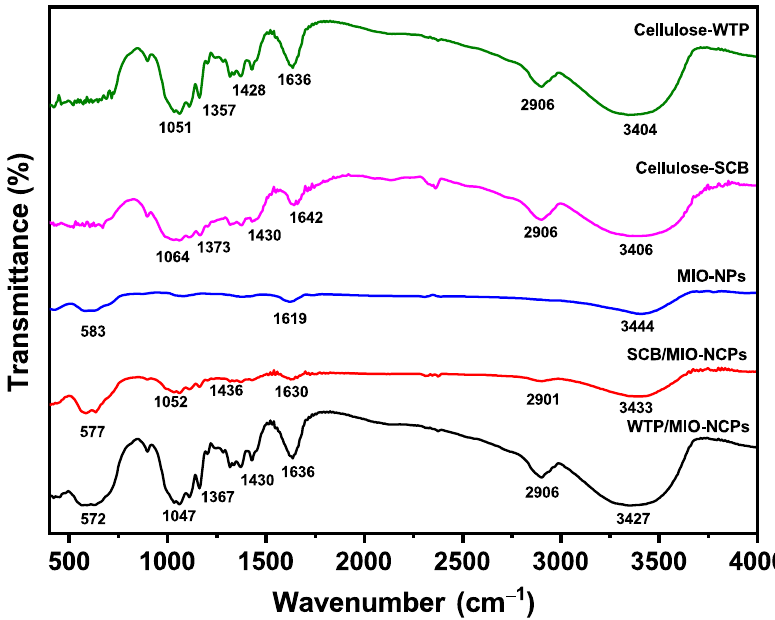
Figure 5. FTIR spectra of cellulose-SCB, cellulose-WTP, MIO-NPs, WTP/MIO-NCPs, and SCB/MIO-NCPs.